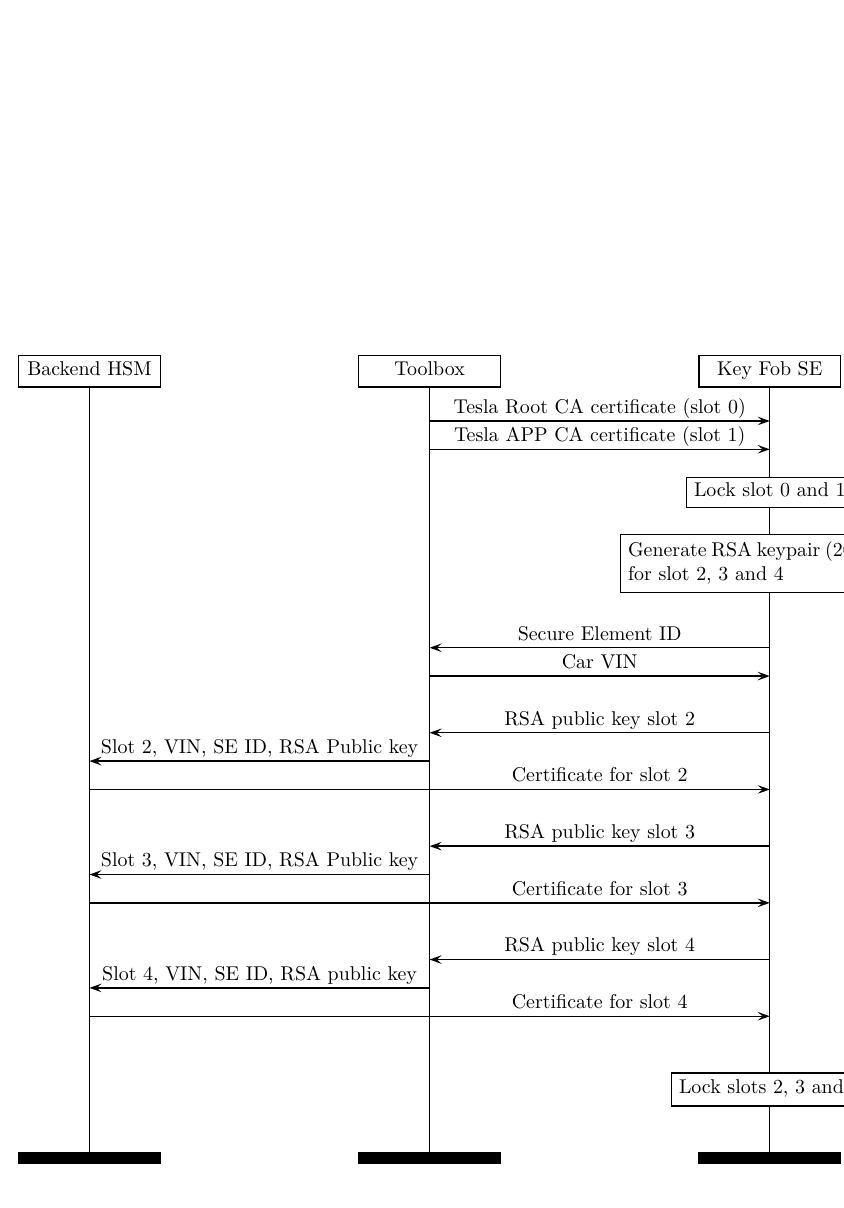
Figure 6: The provisioning protocol as it is used during normal operation. The key fob Secure Element has five RSA slots, each slot can store a 2048-bit RSA key pair as well as an associated certificate. Once a slot is locked the contents can not be overwritten unless it is first unlocked using a signed APDU command generated by the backend